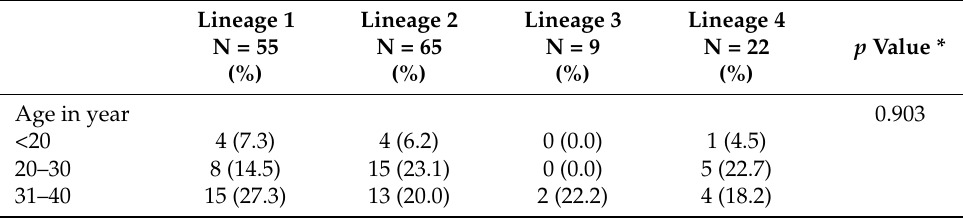
Table 1. Frequency (%) of major lineages of Mycobacterium tuberculosis by demographic